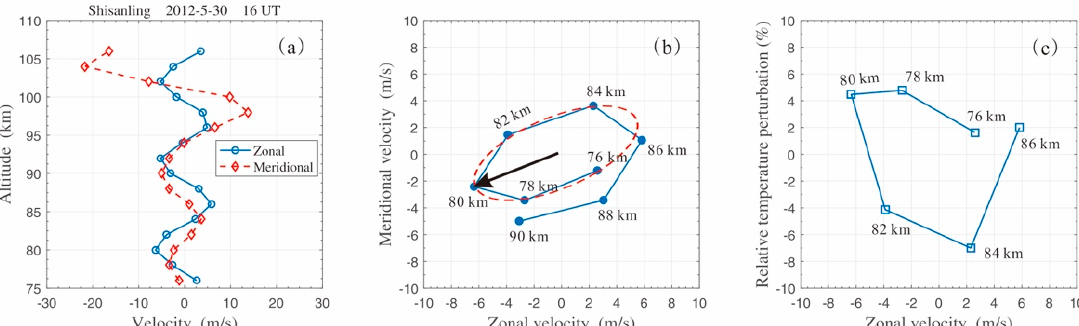
Figure 5. ( a ) Vertical profiles of horizontal wind perturbations measured with meteor radar at 16 UT on 30 May 2012. A bandpass filter was applied to the wind data, with cutoffs at 5 km and 17 km. ( b ) Hodograph analysis for zonal and meridional wind perturbations. By using the least squares method, hodograph (solid line with dots) was fitted with an ellipse (red dashed line) in the 76–86 km altitude range. The black arrow indicates the horizontal wave propagation direction. ( c ) Hodograph analysis for zonal wind and temperature perturbations in the 76–86 km altitude range.